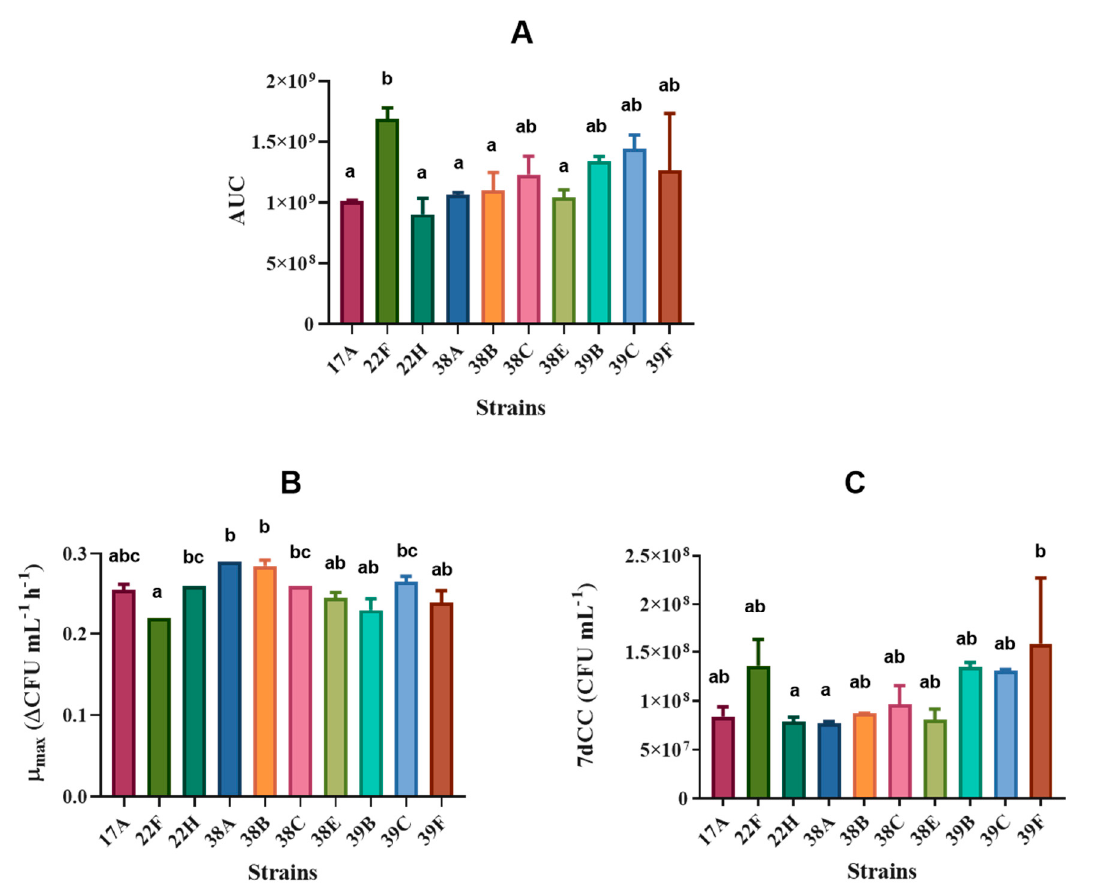
Figure 2. Growth parameters recorded for the different S. cerevisiae strains grown in sterile grape Garnacha must. ( A ): Area Under the Curve (AUC) calculated from the growth kinetics data; ( B ): the maximum growth rate ( µ max ) expressed as ∆ CFU mL − 1 h − 1 ; ( C ): 7-day cell concentration (7dCC) expressed as CFU mL − 1 achieved at 7 days of fermentation. Different letters in the columns mean a significant difference ( p < 0.01) between the